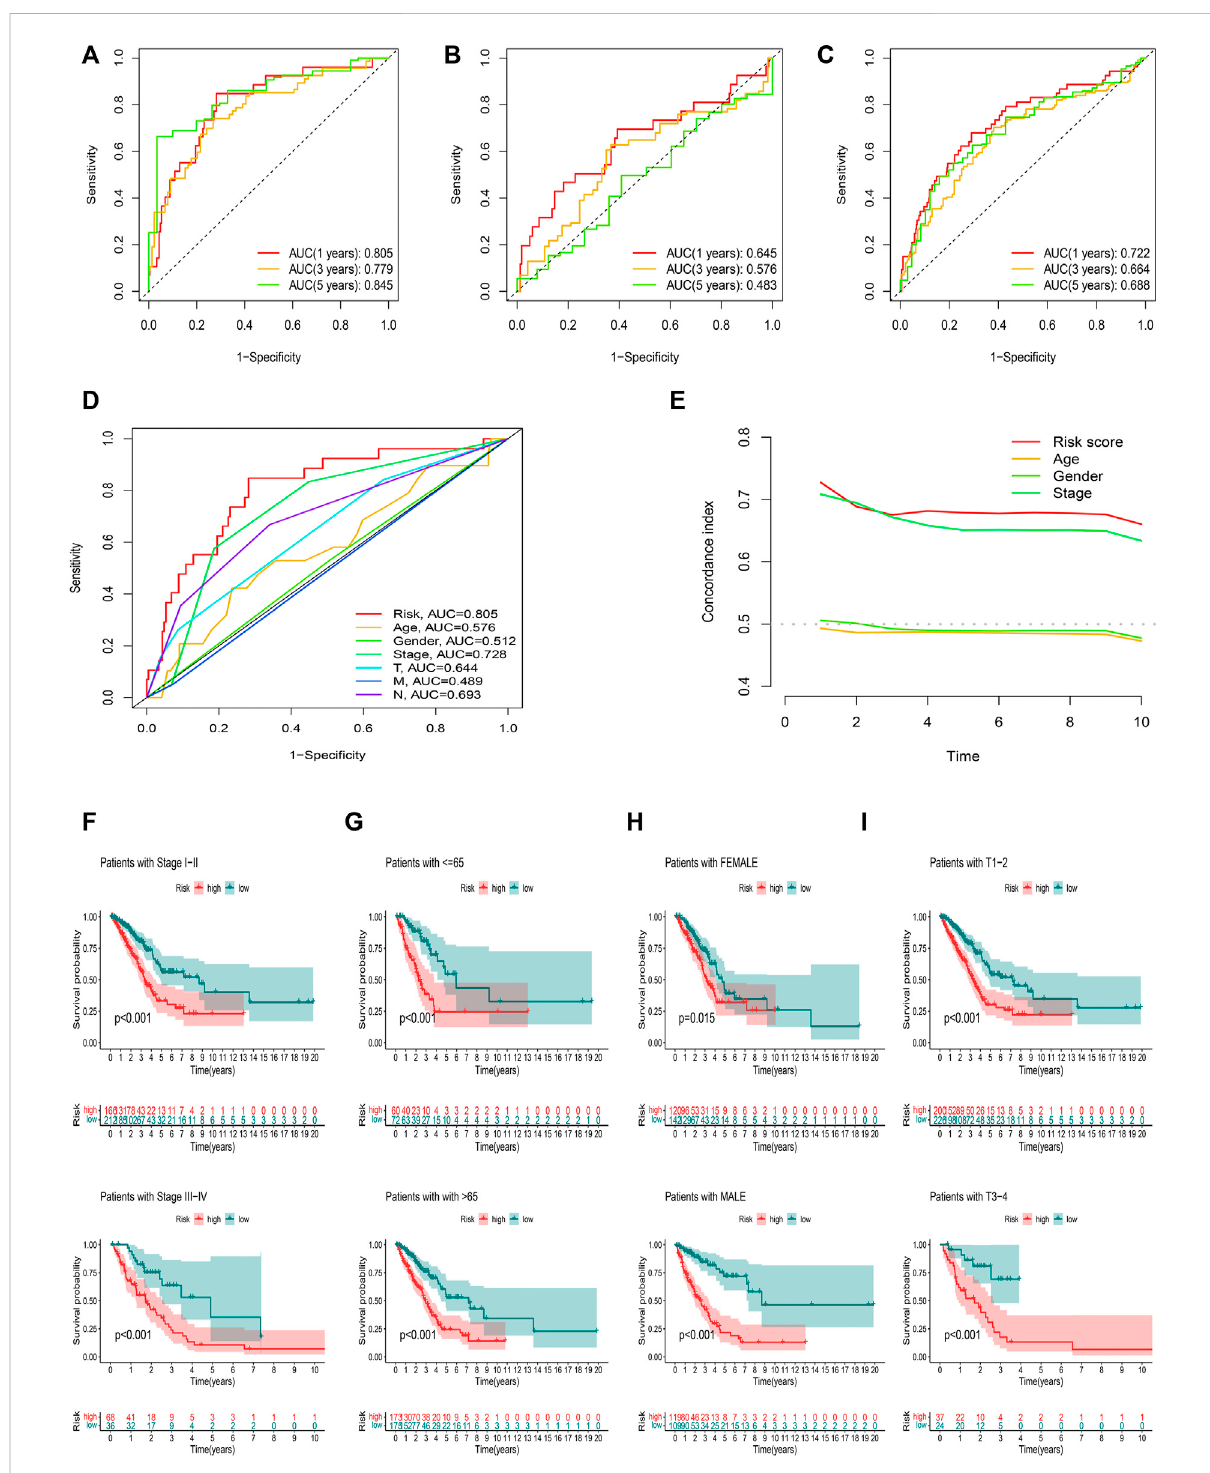
FIGURE 7 Assessment of the prognostic risk model. (A – C) The 1-, 3-, and 5-year ROC curves of the training, testing set, and entire set. (D) ROC curves of all included features. (E) CI ofthe risk score and clinical characteristics. (F – I) OS curveof difference clustered by LUAD clinical features betweentwo risk groups in the entire